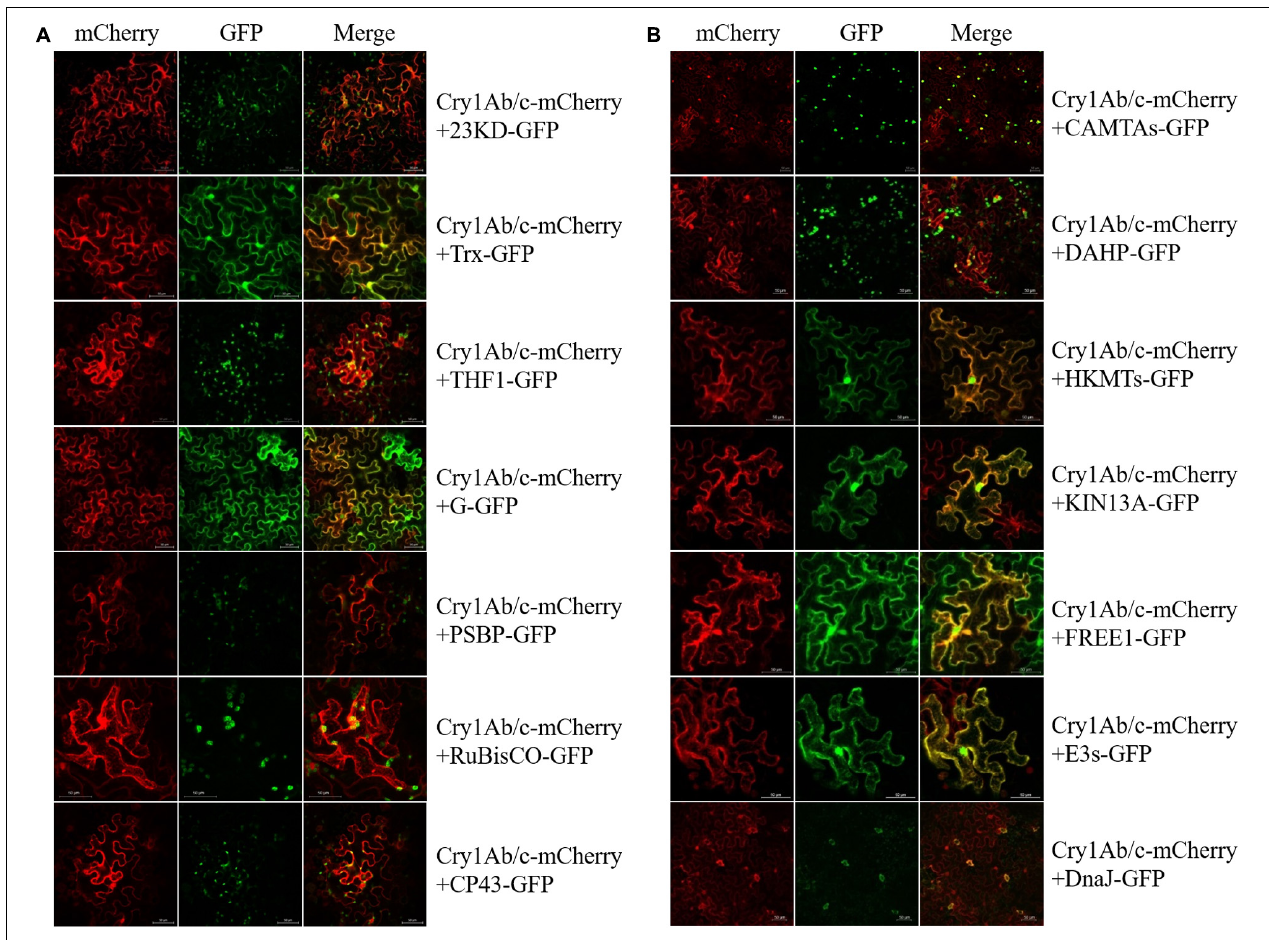
FIGURE 3 | Subcellular co-localization of Cry1Ab/c and 14 endogenous proteins involved in photosynthesis and stress resistance. The co-localization sites and strength of photosynthetic proteins (A) and stress resistance proteins (B) were detected by in situ mCherry and GFP fluorescence, scale bars: 50 µ